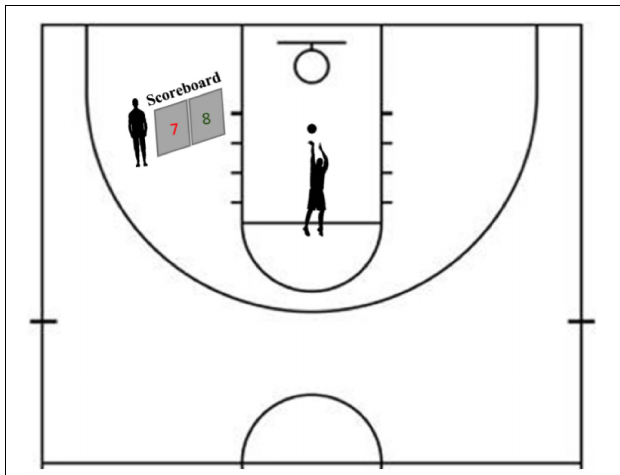
FIGURE 1 | Graphical representation (not to scale) of the